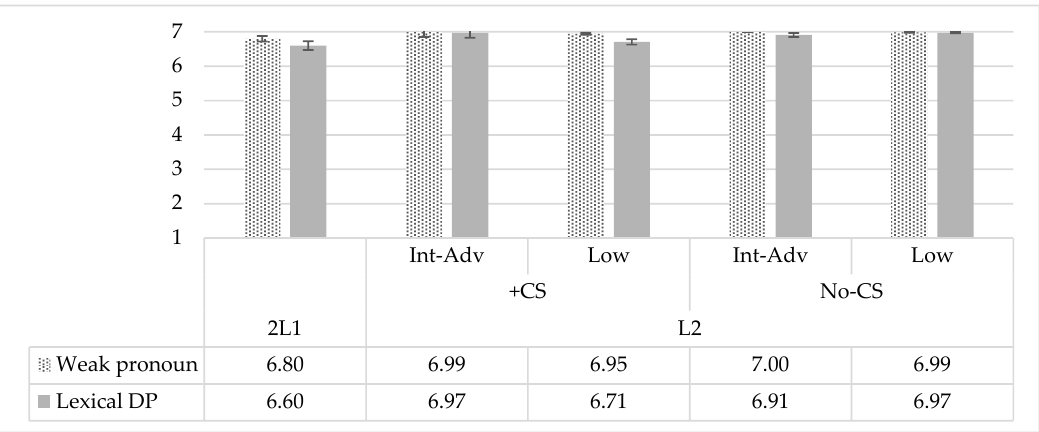
Figure 6. Monolingual English subject stimuli ratings by group and type. DP: determiner phrase.